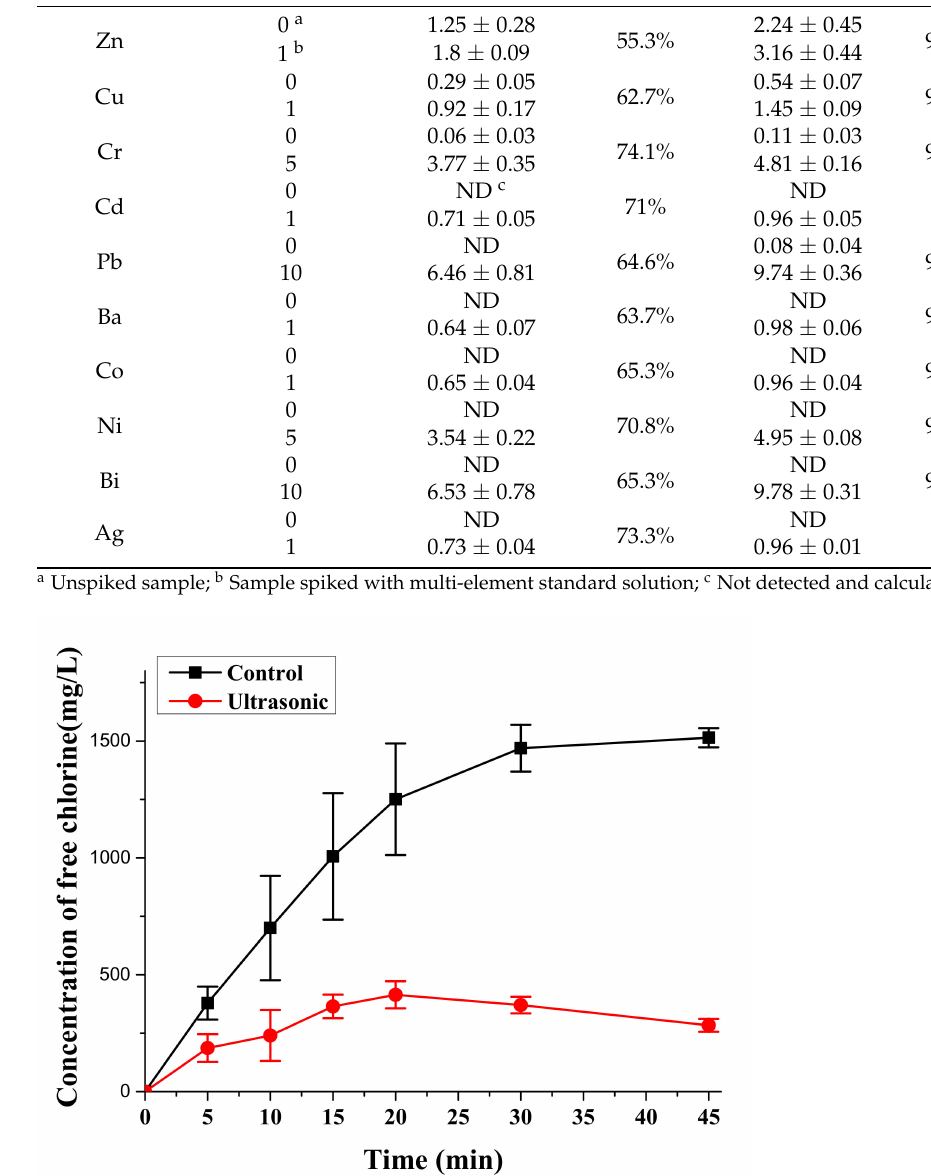
Table 1. Concentrations and recovery rates (%) in the spiked samples digested by the UAEO method. Element